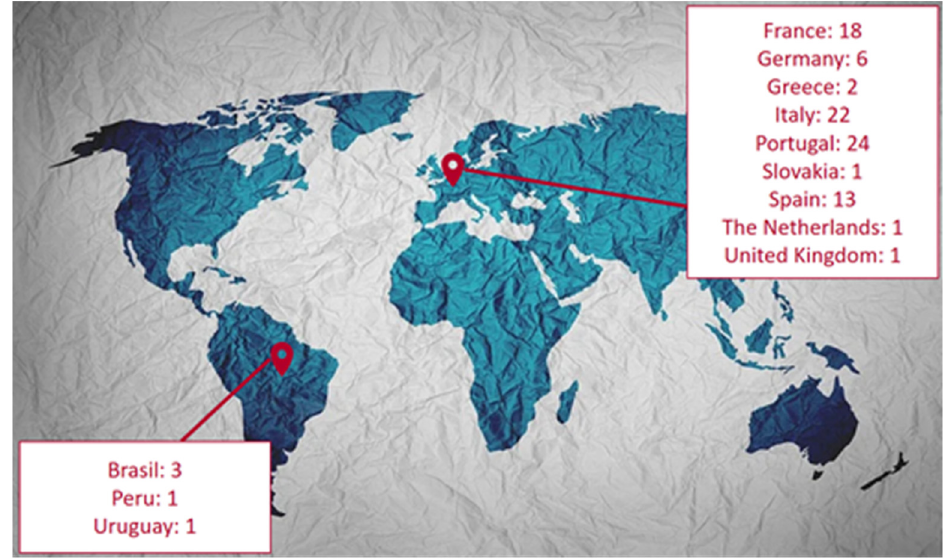
Figure 8. Nationalities of the 93 MOOC finalists.